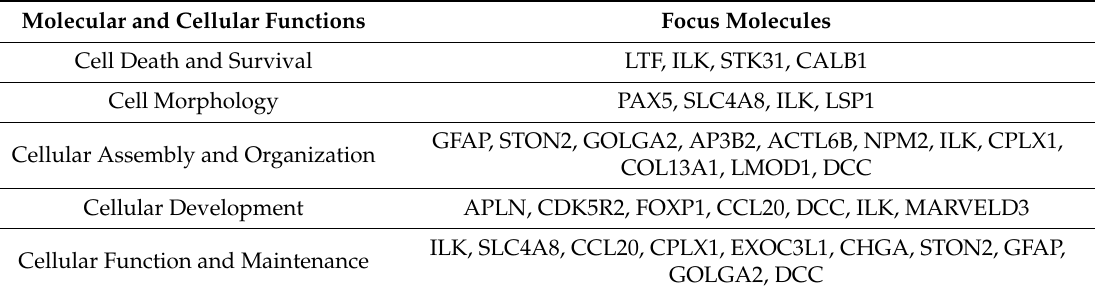
Table 6. Top 5 molecular and cellular